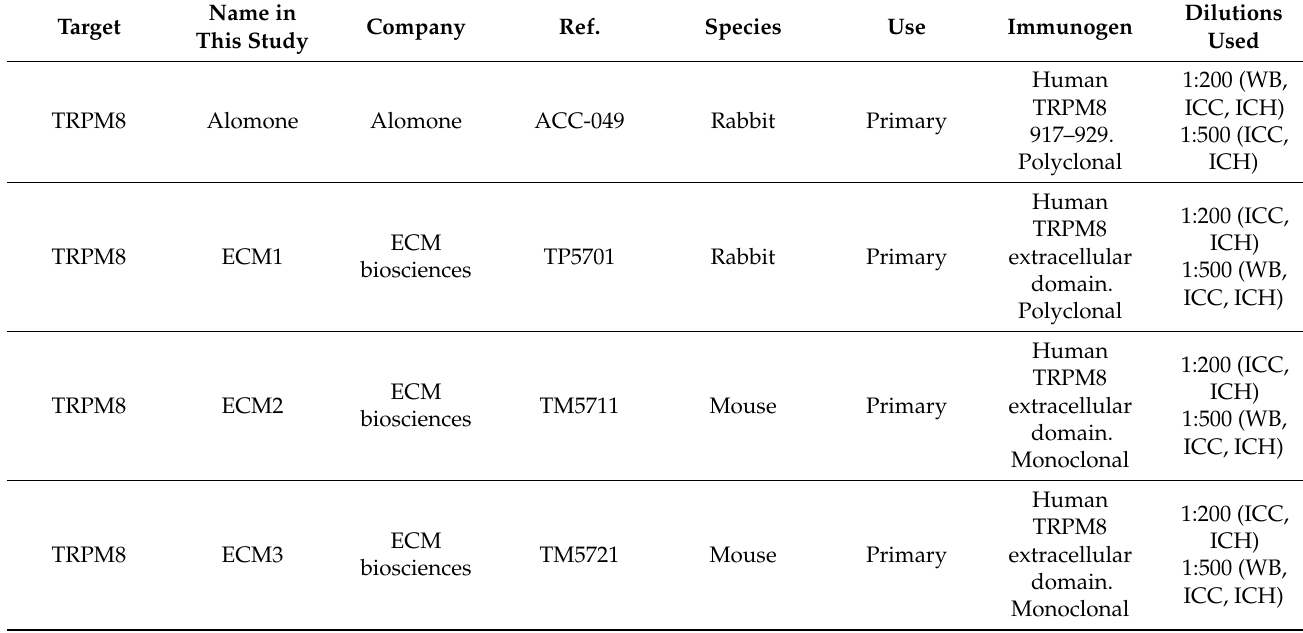
Table 2. Antibodies used in this